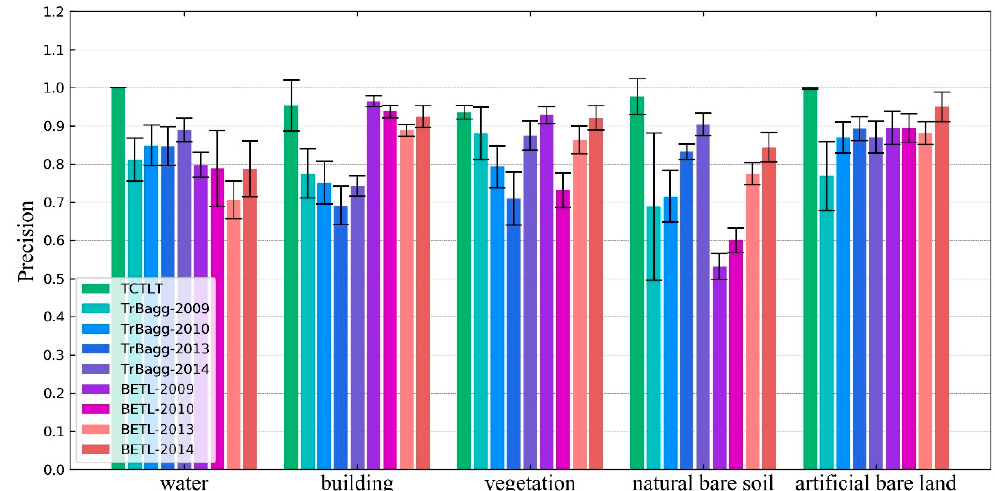
Figure 12. The mean and standard deviation of the label transfer precision of the different objects.